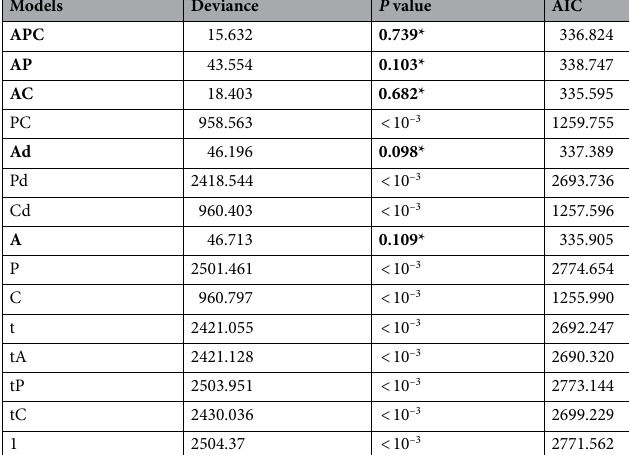
Table 2. Deviance tables of age-period-cohort model all sexes combined. * p ≥ 0.05. AIC Akaike Information Criterion. All models are defined in the footnote of Fig. 5. Analysis of the deviance of the age-period-cohort model for all sexes combined. The p -value of each nested model is analyzed. For p ≥ 0.05, the corresponding model cannot be rejected; the parameters contained in this model may have affected the evolution of MS incidence over the study period. Sub-models at p < 0.05 can be rejected: there is no effect of the parameters contained in this sub-model that is